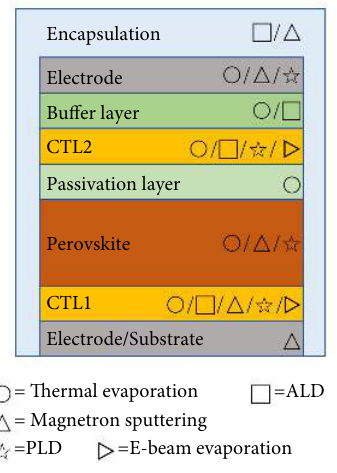
Fig. 9 Schematic illustrations of fully-vacuum deposited